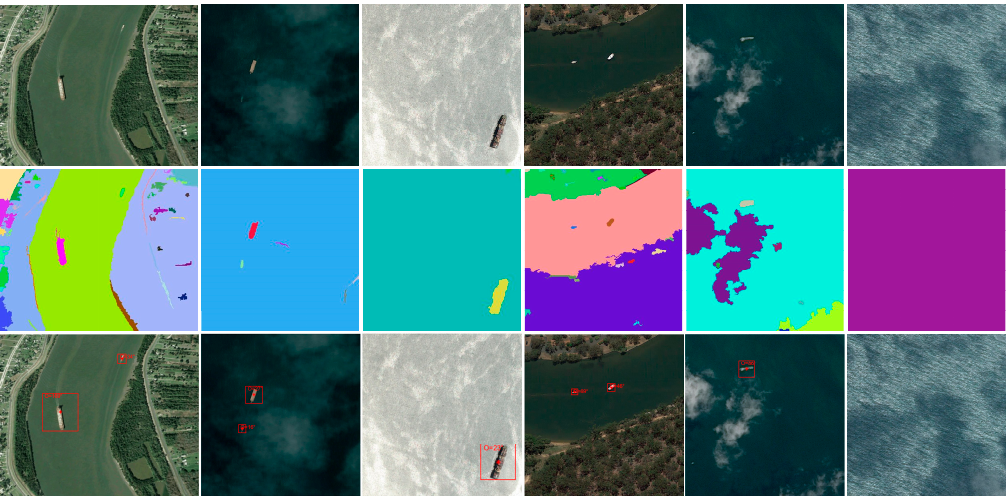
Figure 14. The detection results of our overall detection algorithm. The first row corresponds to the input image. The second row presents the result of the segmentation. The last row is the final detection result after false alarm rejection. Besides, the main orientation of the target is also estimated.